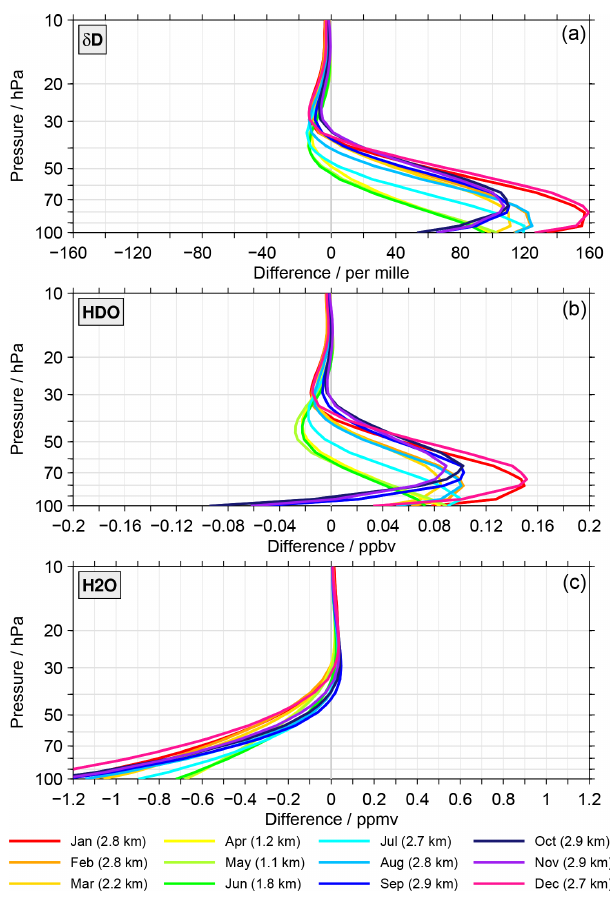
Figure 6. Differences in δ D (a) , HDO (b) and H 2 O (c) between the test and standard retrieval as a function of altitude and colour- coded for the calendar months. The calculation of these monthly mean differences follows Eqs. (A8) and (A11) in the Appendix. In the legend also the change of the start altitude between the two re- trievals is indicated for the individual months, derived according to Eq.